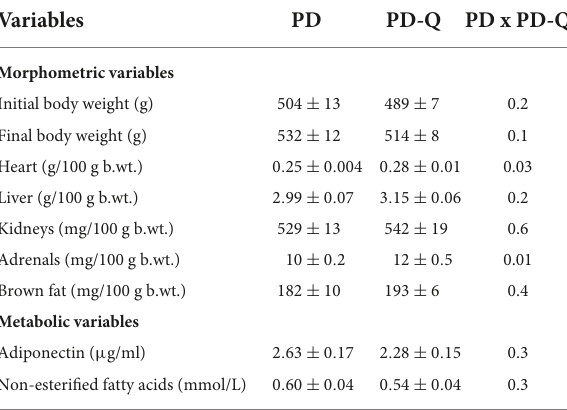
TABLE 1 Effect of quercetin supplementation on morphometric and metabolic variables in male PD rats.